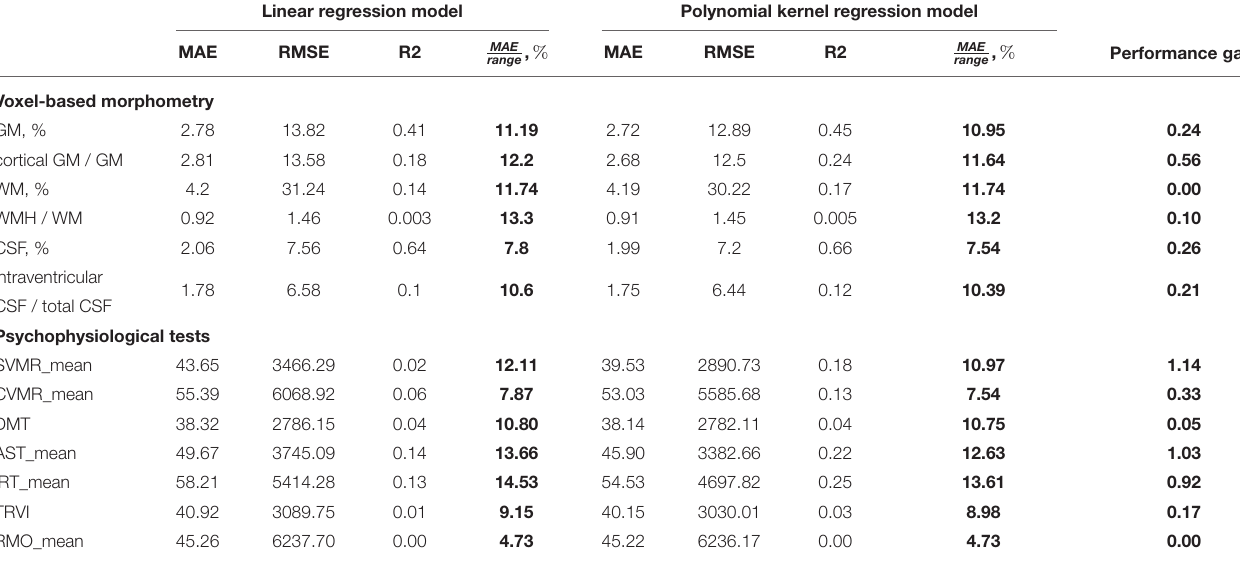
TABLE 4 | Performance of linear and non-linear ML regression models using age to predict results of psychophysiological tests. Linear regression